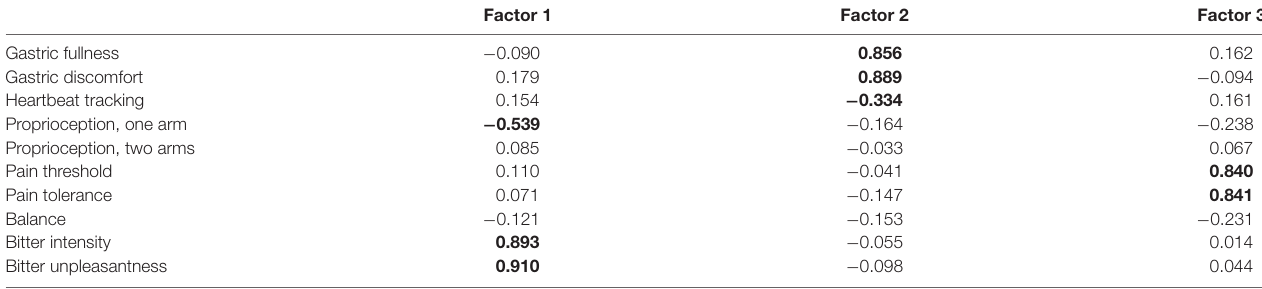
TABLE 2 | Variables’ loadings on the three factors yielded by principal component analysis (PCA) with Oblimin rotation (values larger than 0.3 are marked with bold).